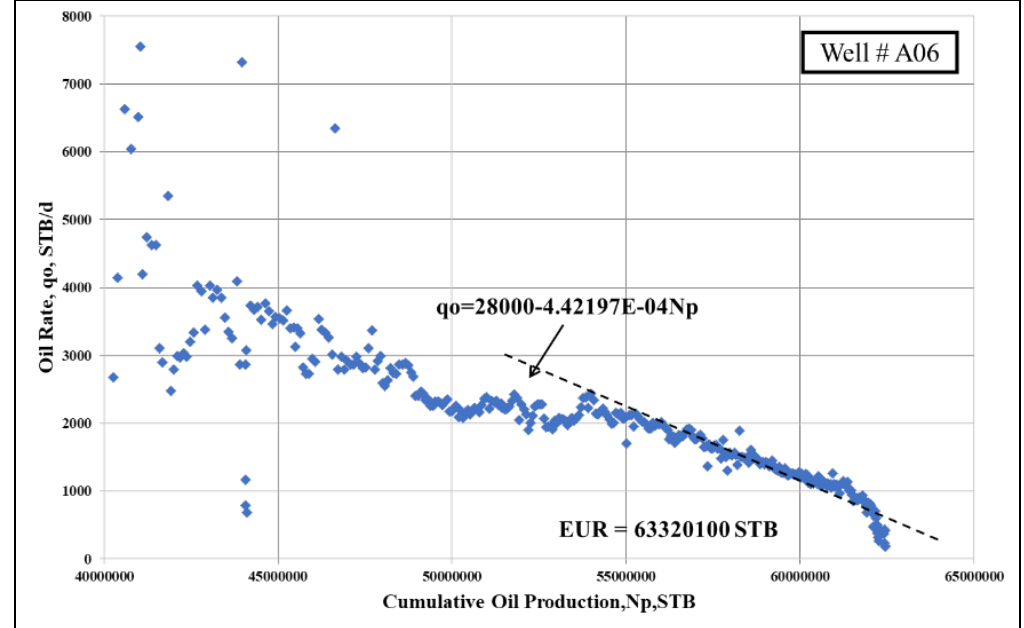
Figure 6. Oil production rate versus cumulative oil production for well A06